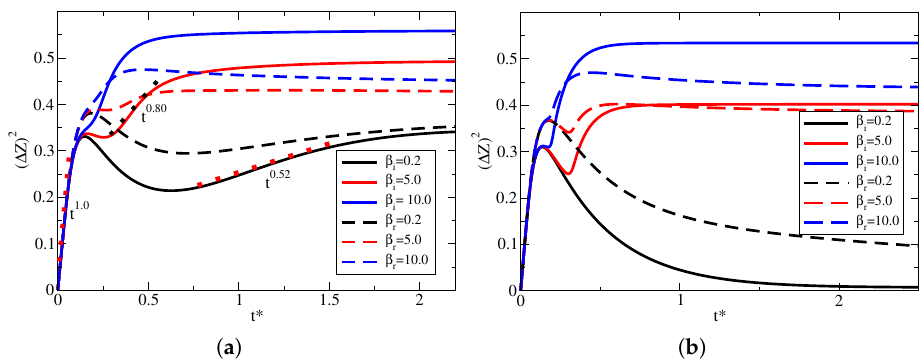
Figure 5. Mean square displacement (MSD) vs. t ∗ for several values of β . The solid curves repre- sent the case in which both surfaces are equal, while the dashed curves represent the MSD for the Z = 1 surface in the case of non-equal surfaces. ( a ) shows the case in which τ κ i / τ i = 1, while ( b ) shows the case in which τ κ i / τ i = 0.01 (identical surfaces and right surface for the non-identical case). The dotted lines in ( a ) show examples of the exponent ( t a ) of the MSD, indicating the subdiffu- sive behavior of the